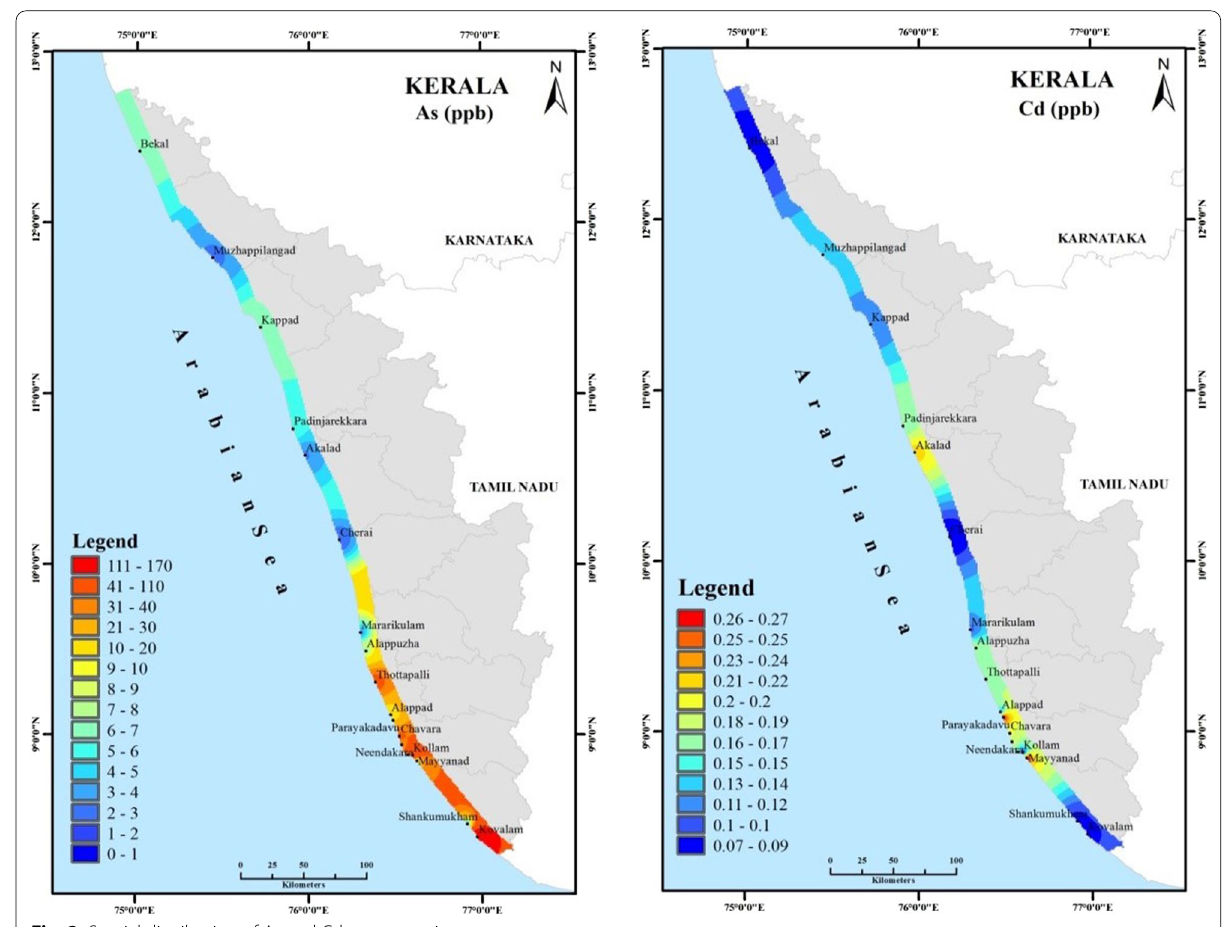
Fig. 2 Spatial distribution of As and Cd